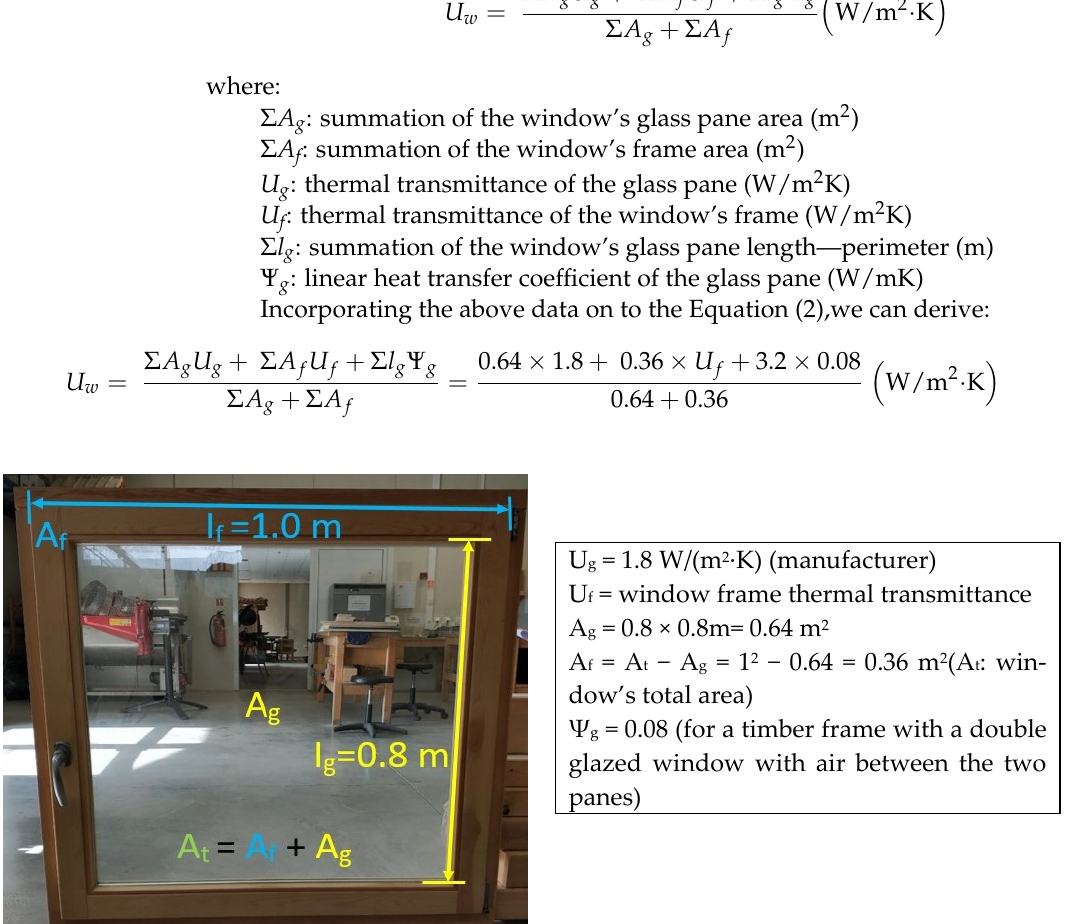
Figure 2. The tested wood-frame window.